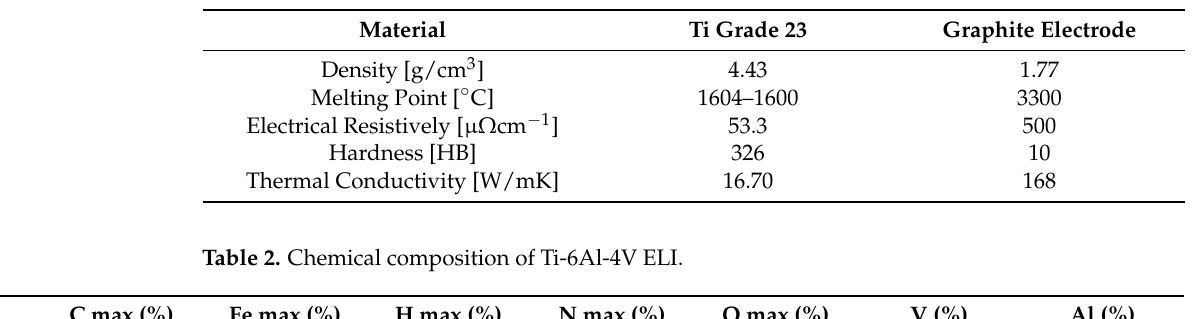
Table 1. Mechanical properties of the Ti-6Al-4V ELI, and the graphite electrode.